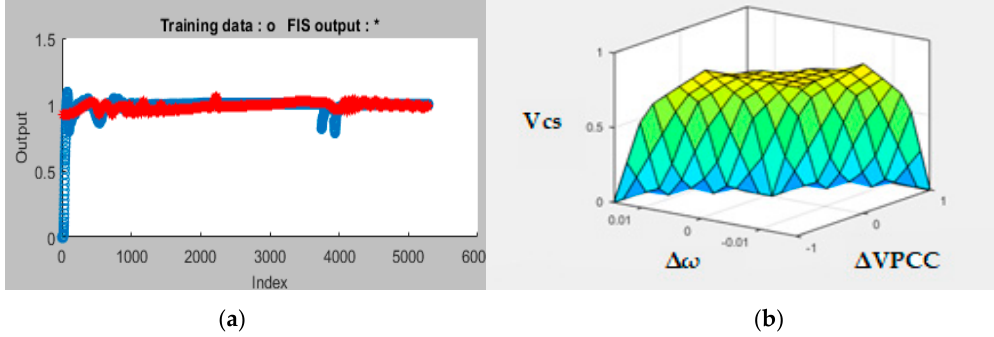
Figure 6. ANFIS model structure.